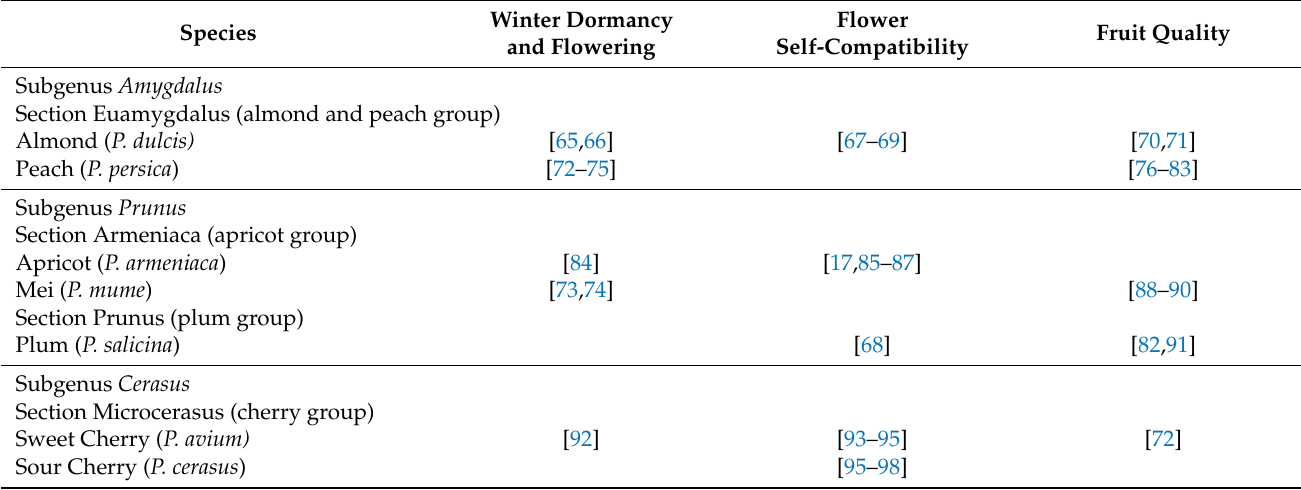
Table 1. Identified mutations related to most important agronomic traits in Prunus